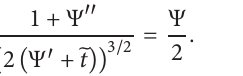
̃𝑏 = 1.6608 as functions of 2